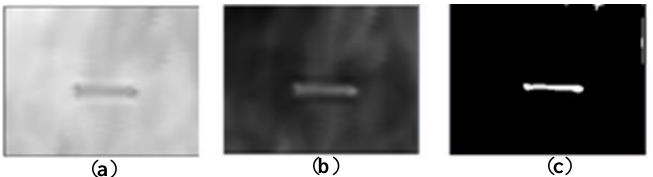
Figure 22. Images of notch 1 under the 2 mm-thick rubber layer obtained at a standoff distance of 0.1 mm: ( a ) original and after ( b ) average filtering, and ( c ) thresholding by the developed fuzzy c-mean thresholding algorithm.